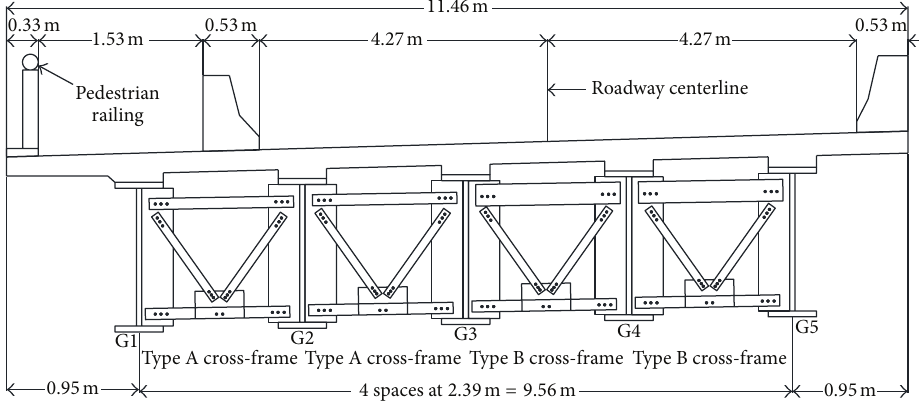
Figure 1: Studied bridge framing plan [5].